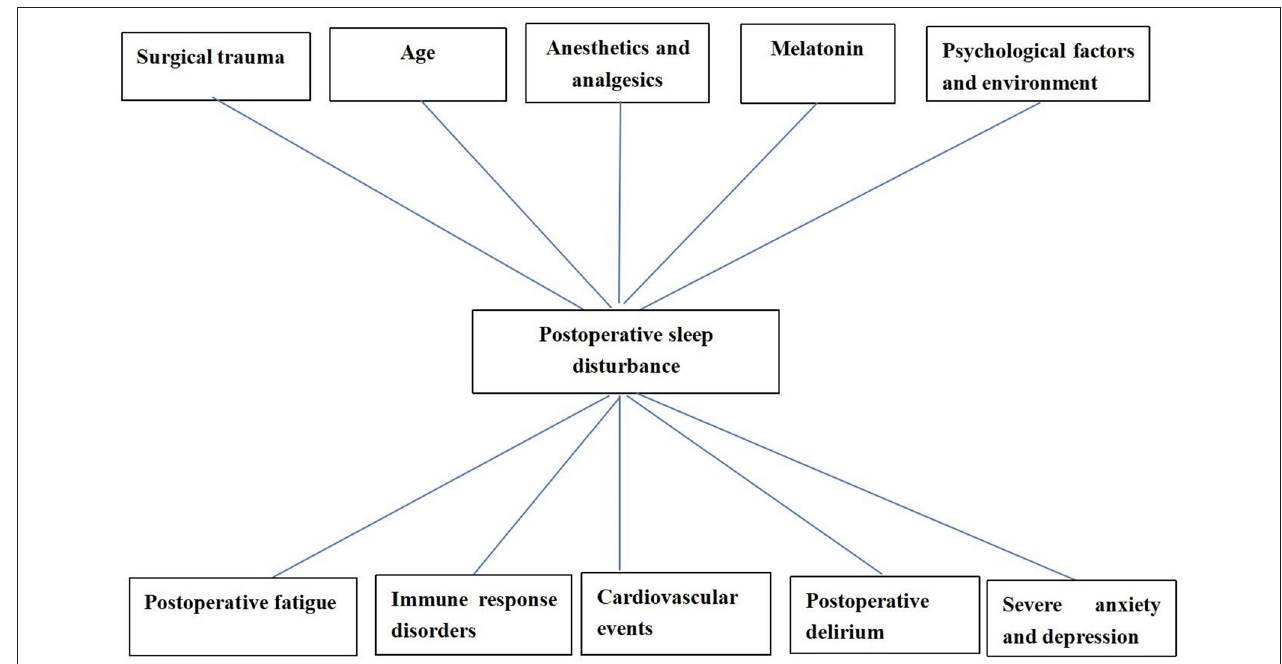
FIGURE 1 | The common acupoints in the treatment of sleep